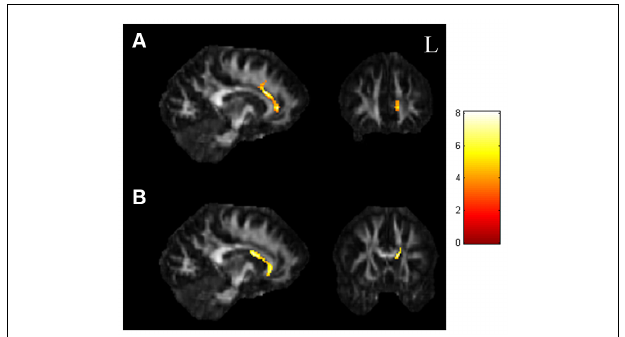
FIGURE 1 | ANCOVA results of GFA and NQA. (A) The GFA value showed significant differences in the corpus callosum and anterior cingulate among the three groups. (B) The NQA value showed significant differences in the corpus callosum and anterior cingulate among the three groups ( p < 0.05, cluster size > 100, color bar: F scores). GFA, generalized fractional anisotropy; NQA, normalized quantitative